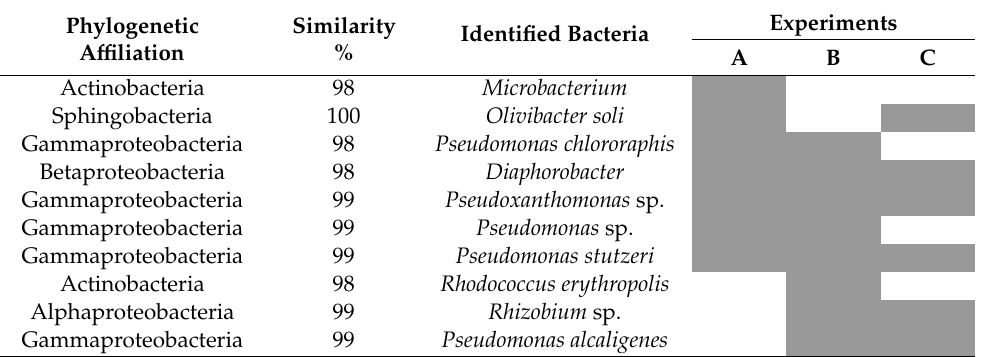
Table 4. Identification and phylogenetic assignation (RFLP, Restriction Fragment Lenght Polymorfism) of culturable bacteria isolated from the three bioslurry experiments. Gray fills indicate the presence of the bacteria in the corresponding